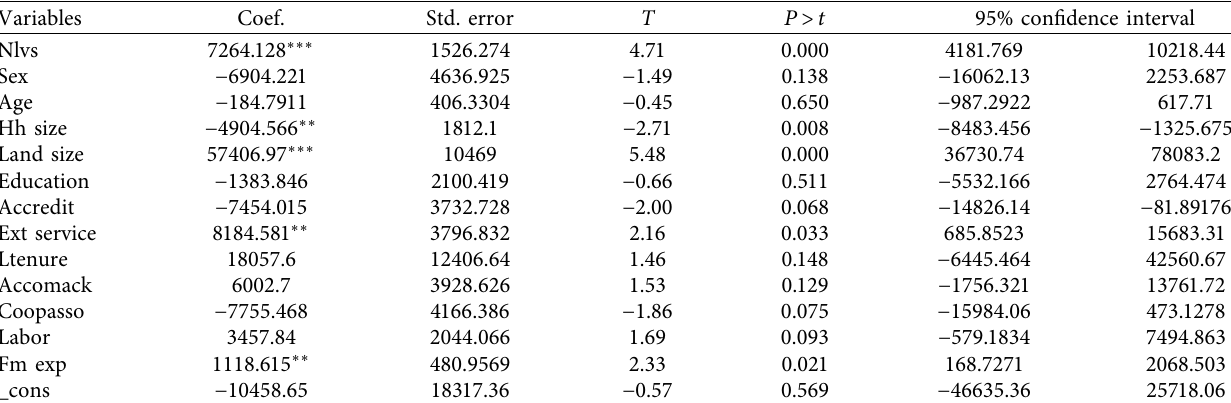
Table 6: Multiple regression results of the factor that infuences the household’s farm income from AFP ( N � 173). Variables Coef. Std. error